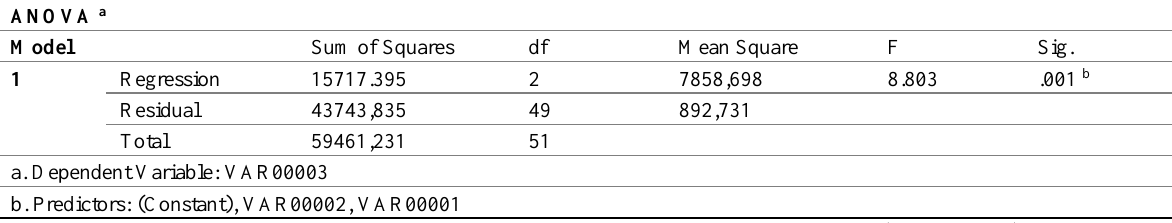
Table 8: F- Test Results